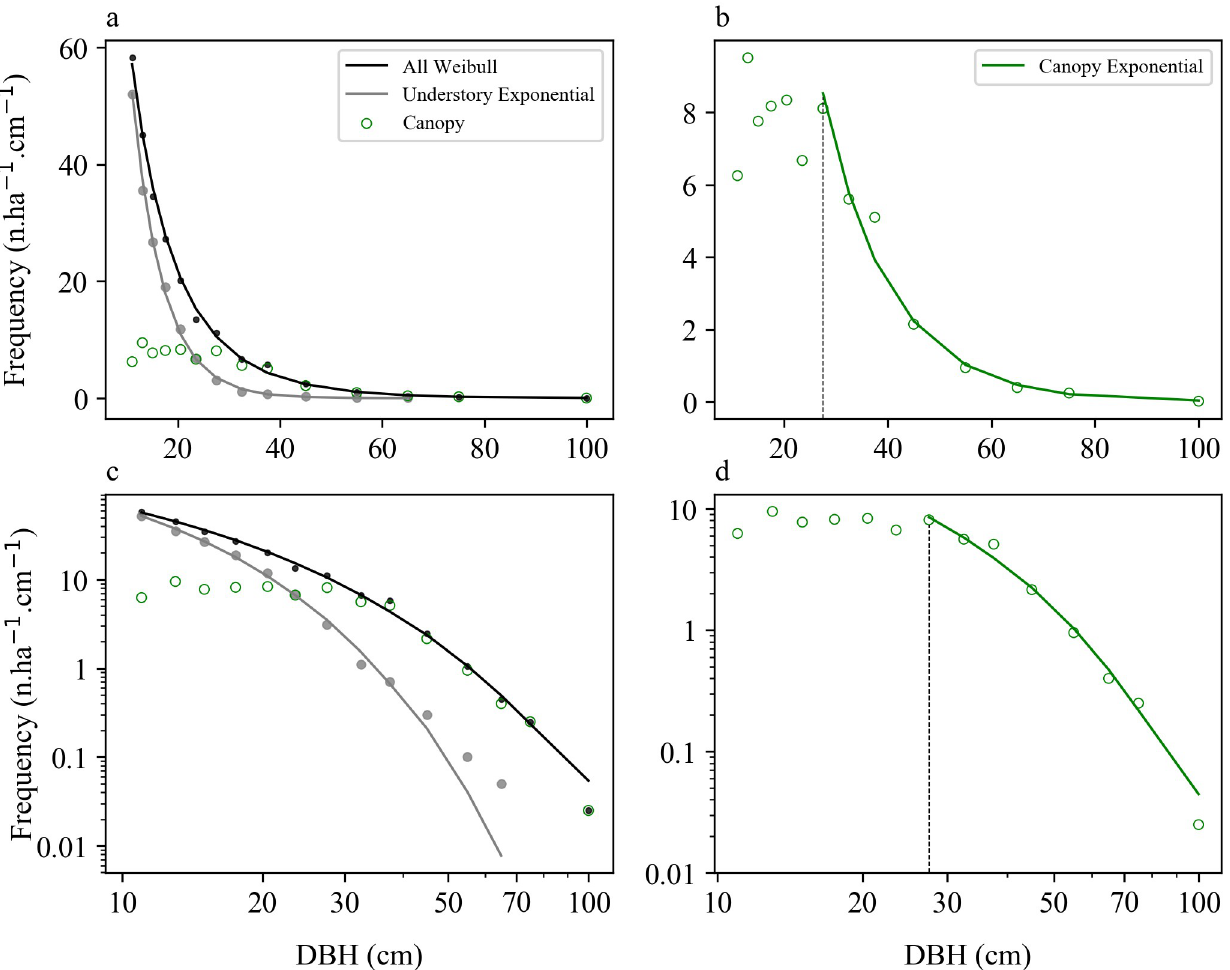
Fig 5. Observed size distributions of understory trees, canopy trees, and both combined. Size distributions of all 1244 trees with DBH > 10 cm (black points), understory trees (gray points), and canopy trees (green circles), shown together with best-fit probability density functions (lines). Distributions are shown on both linear (top) and log (bottom) scales. The vertical dashed black line indicates the minimum diameter (25 cm) for inclusion in the canopy tree fits. The Weibull distribution (Eq 6) had the best fit for all individuals combined; the exponential distribution (Eq 4) had the best fit for understory trees as well as for canopy trees with DBH � 25 cm. Whereas data are graphed here for 10-cm size classes for visualization purposes, fits were carried out using 1-cm size classes (parameter values in Table 2).